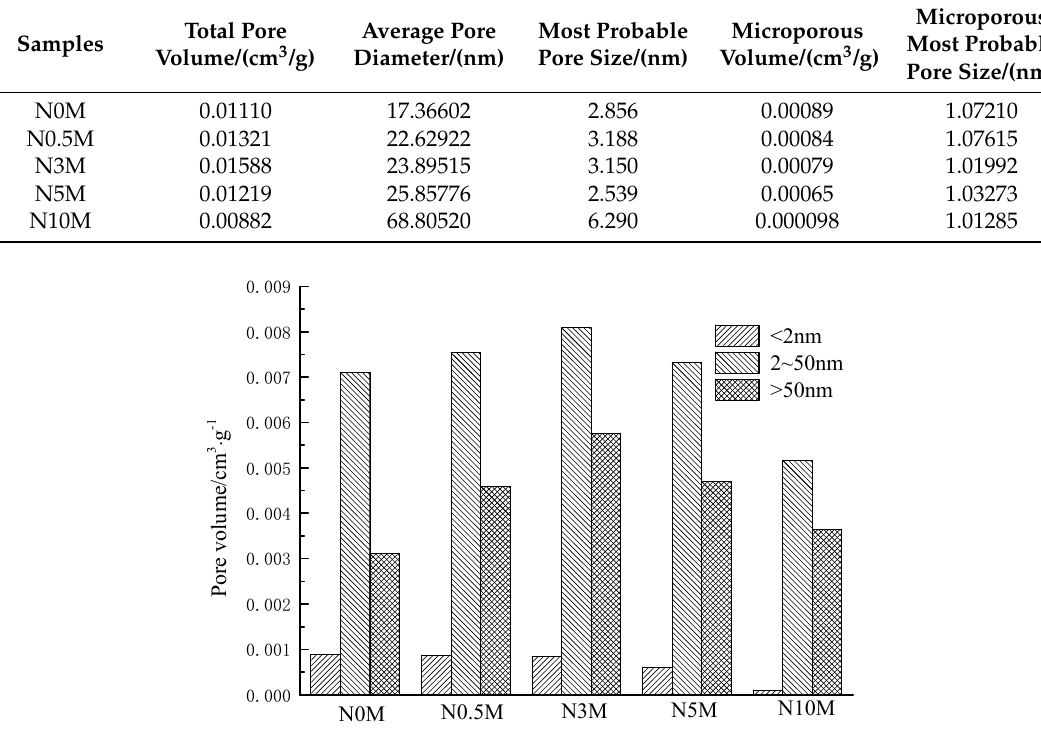
Figure 4. Pore volume of lignite treated with different concentrations of nitric acid.